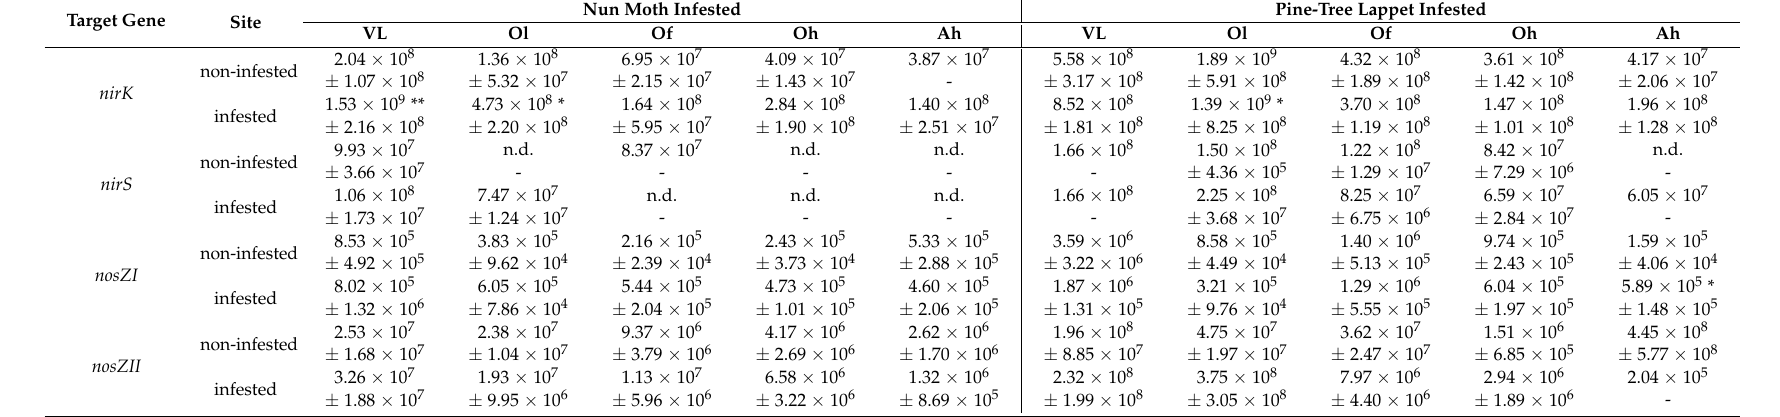
Table 1. The mean ± standard error of the nirK , nirS and nosZ I and nosZ II gene copy numbers per of gram dry material of the vegetation layer, organic layer, and the mineral soil of the nun moth ( Lymantria monacha L.) and pine-tree lappet ( Dendrolimus pini L.) infested and non-infested Scots pine ( Pinus sylvestris L.) forest sites. VL = vegetation layer, Ol = litter organic, Of = fibric organic, Oh = humic organic, Ah = humic mineral. (varying sample size, see Table A5, n.d. = not detectable.); the asterisks indicate significant differences between infested and non-infested sites at the same date and layer based on a pairwise Kruskal-Wallis test, ** p < 0.010, * p <